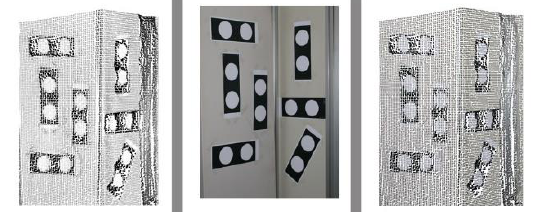
Figure 4.SR 4000 captured point cloud (left), Acquired image of the scene (middle), coloured point cloud (right)